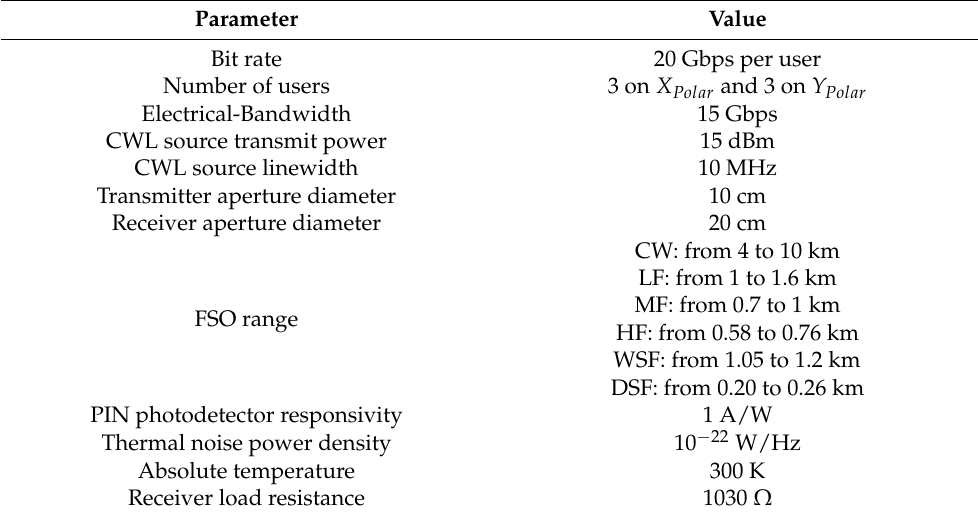
Table 4. Simulation parameters